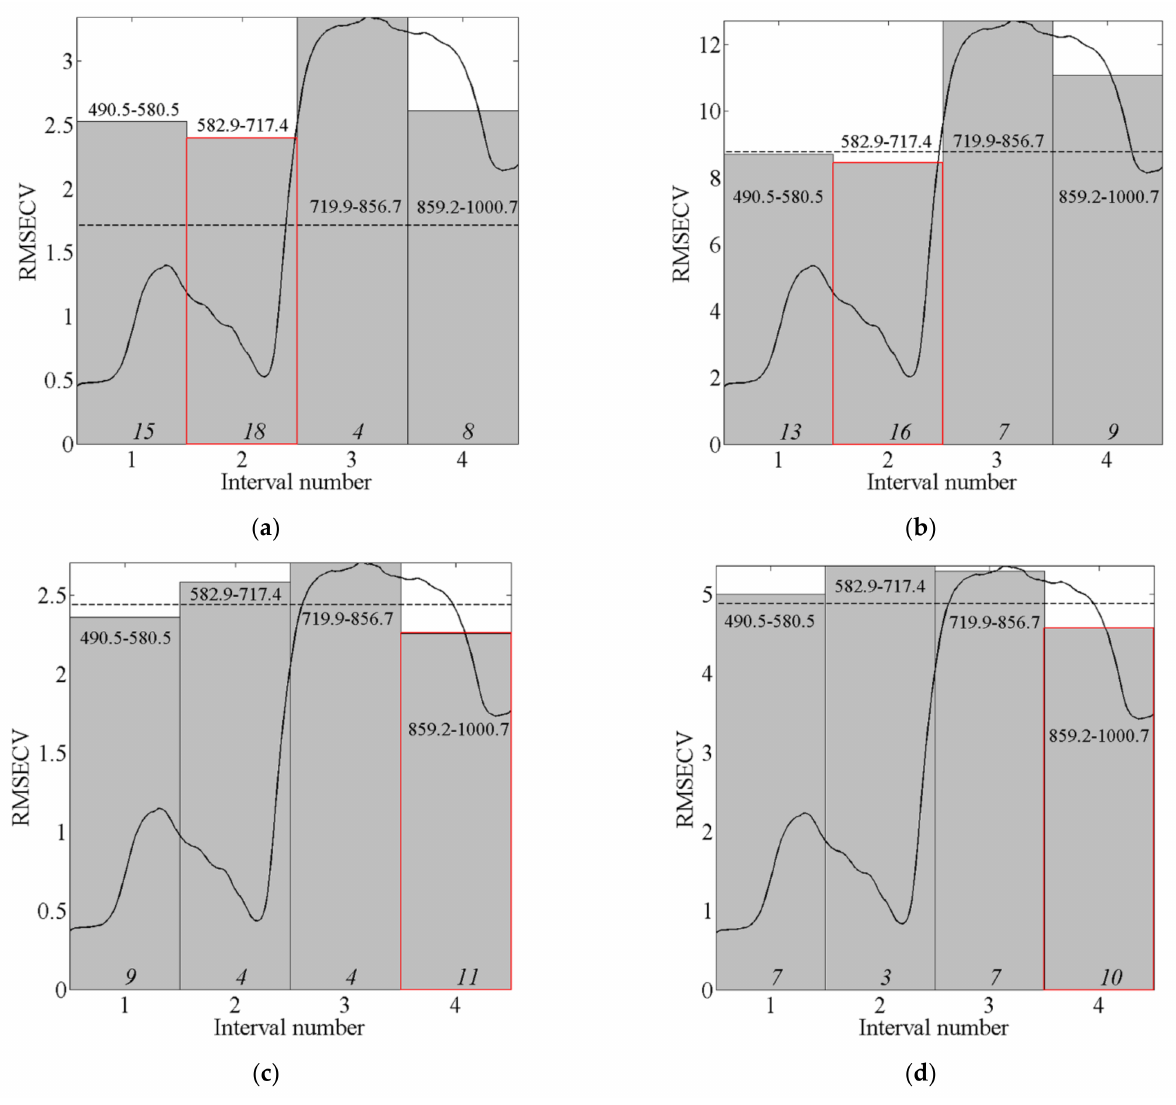
Figure 6. Selection of the optimal intervals for: ( a ) SSC; ( b ) TA; ( c ) chlorophyll and ( d ) ∆